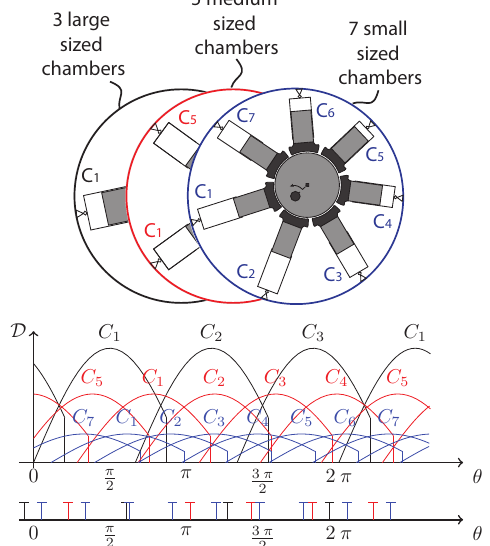
Figure 19: Illustration of a DDM with variable sized displacement